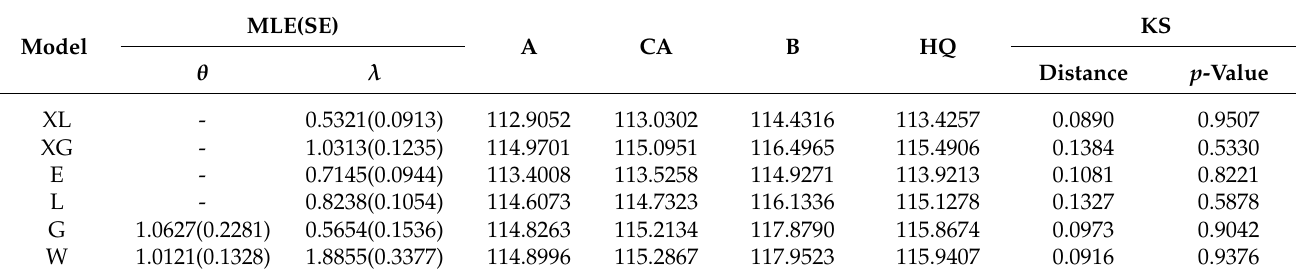
Table 4. Summary fit for the vinyl chloride